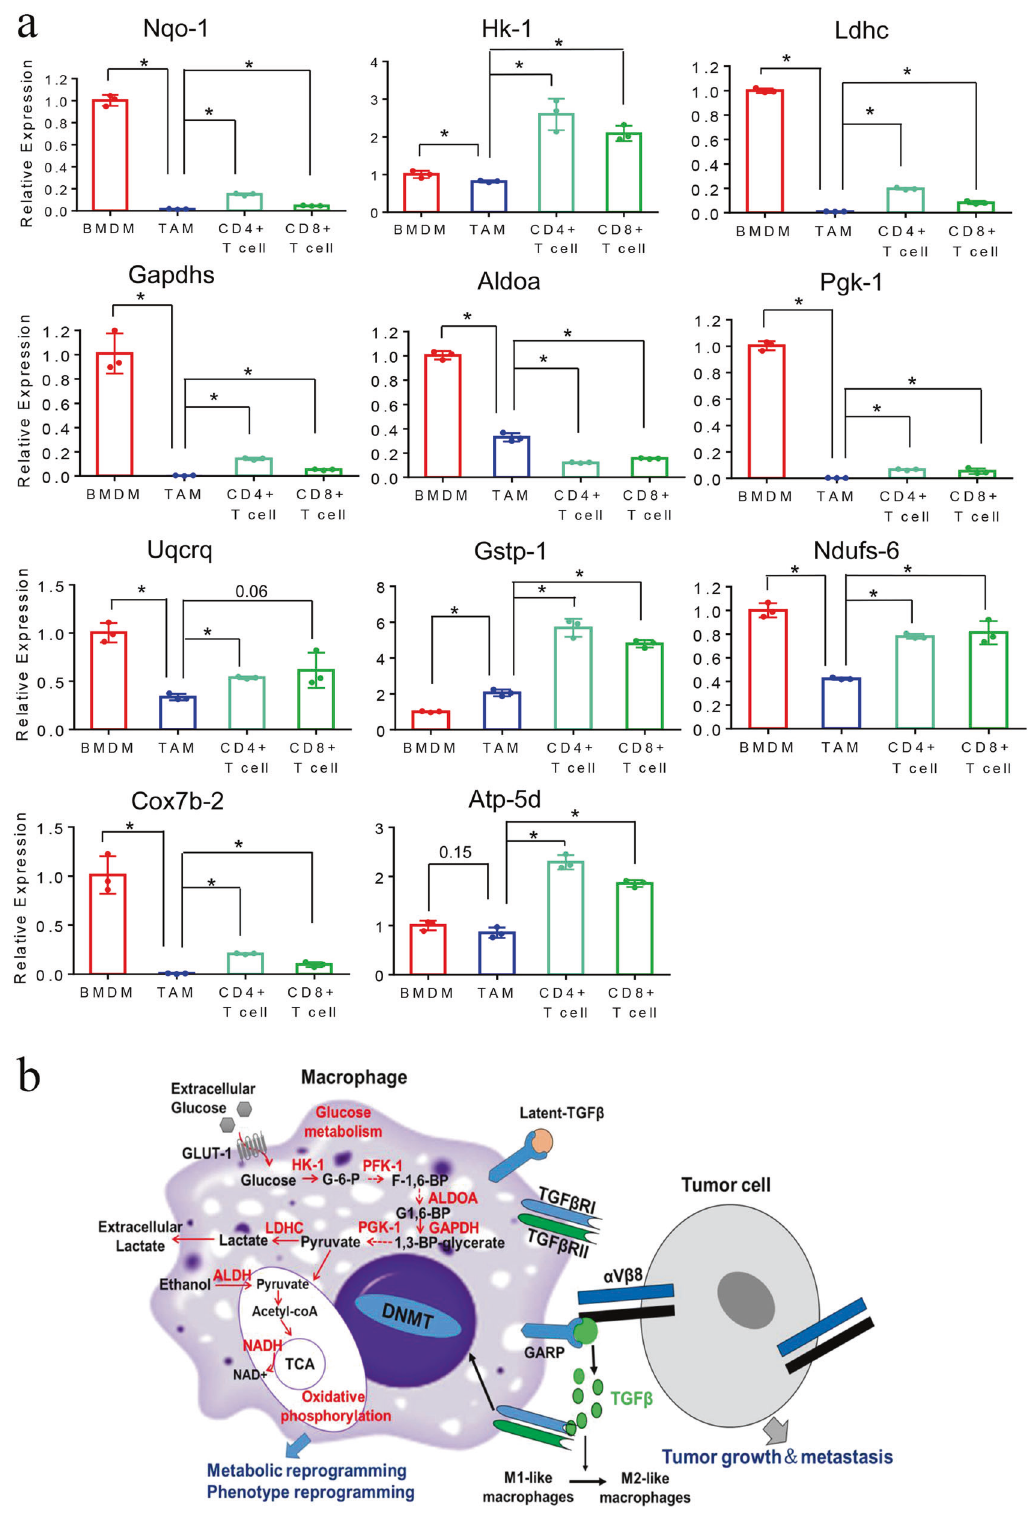
Fig. 6 Downregulation of genes in the metabolic pathway in TAMs from murine PDA. a mRNA expression of metabolism genes as indicated were measured by RT-PCR in TAMs, CD4 + , and CD8 + T cells from primary pancreatic tumors and BMDMs of the same KPC mice. Tumors were identi fi ed by ultrasound before sacri fi ce. β -actin used for normalization. Data are means ± SEM from triplicates and representative of two experiments. * P < 0.05 (ANOVA). b The schematic model of the GARP/integrin-mediated interaction between tumor cells and macrophages in the TME of PDAC and the mechanisms of metabolic, phenotypical, and functional reprogramming of macrophages from M1-like to M2-like macrophages in a DNA methylation-dependent manner